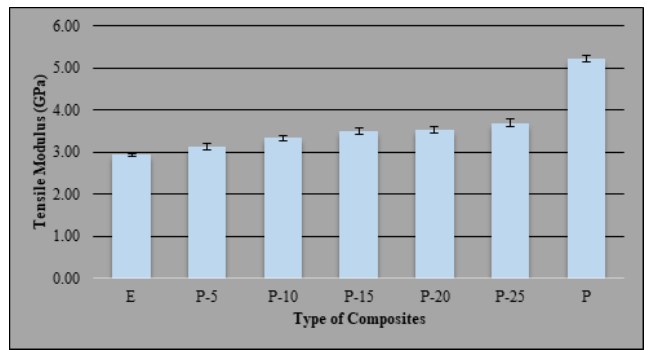
Figure 3. Tensile modulus of bio-phenolic/epoxy polymer blends, neat epoxy, and bio-phenolic material. Scanning electron microscopy was carried out on a fracture surface of the tensile test.